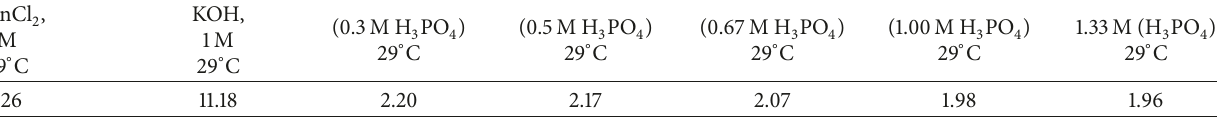
Table 10: pH of the solutions (activating agents).